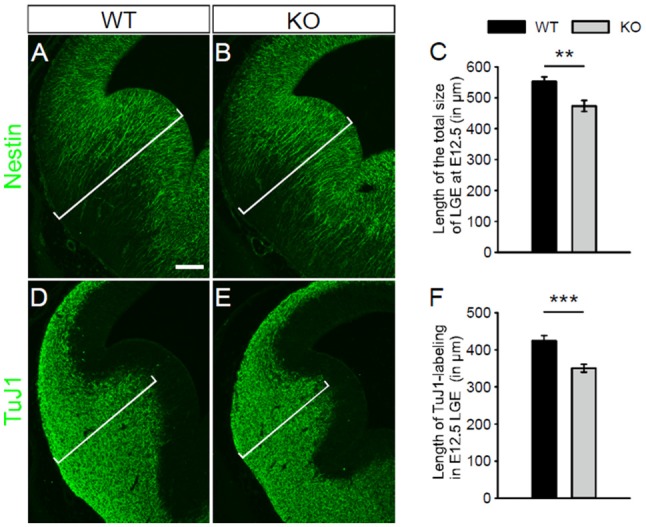
NKCC1-deficient mice exhibit abnormal morphology of the LGE. (A,B) Immunohistochemical staining for nestin in the LGE of WT (A) and NKCC1 KO (B) mice at E12.5. (C) Quantification of the length of the total size of the LGE in WT and NKCC1 KO mice at E12.5. **p < 0.005 (n = 4). (D,E) Immunohistochemical staining for TuJ1 in the LGE of WT (D) and NKCC1 KO (E) mice at E12.5. (F) Quantification of the length of the region containing TuJ1-labeling in the LGE of WT and NKCC1 KO mice at E12.5. ***p < 0.001 (n = 8). Scale bar 200 μm in (A).